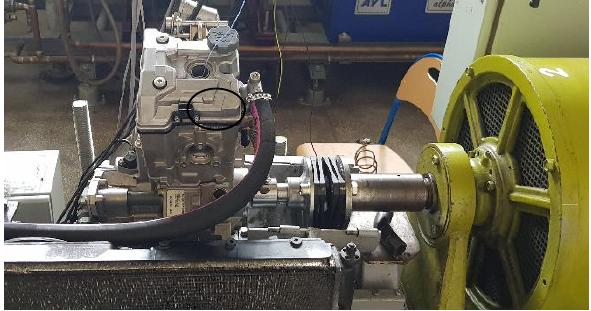
Fig. 4. Experimental setup installed at the